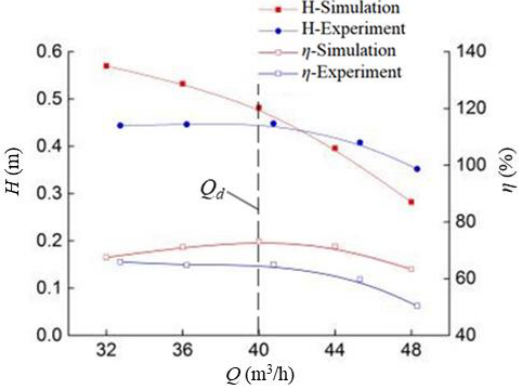
Figure 5. Comparison of numerical simulation and experimental results.